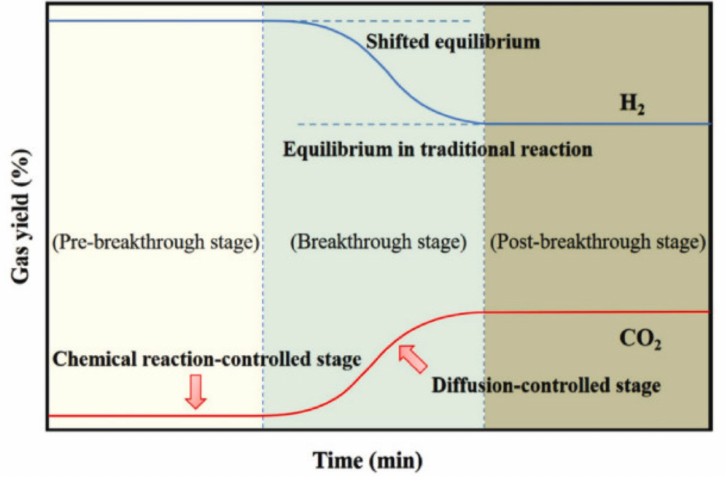
Figure 9. Scheme of the three-stage of SERP with Ca-based sorbents: pre-breakthrough stage, break- through stage and pre-breakthrough stage. (Reprinted with permission from [38]. 2021, Ma et